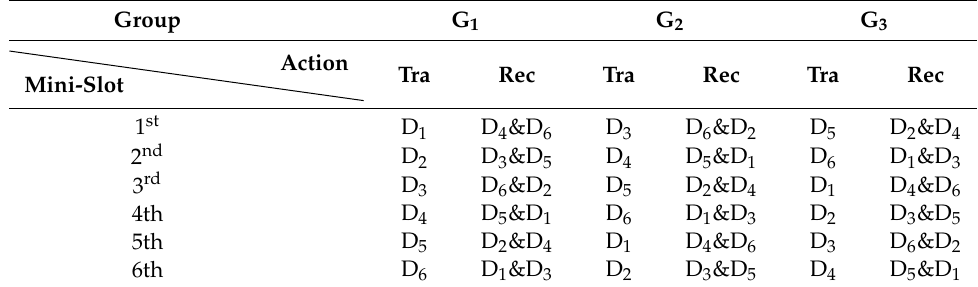
Table 1. Arranged transmission and reception directions for sensors in di ff erent groups and di ff erent mini-slots. The Tra and Rec represent the transmission action and reception action, respectively.